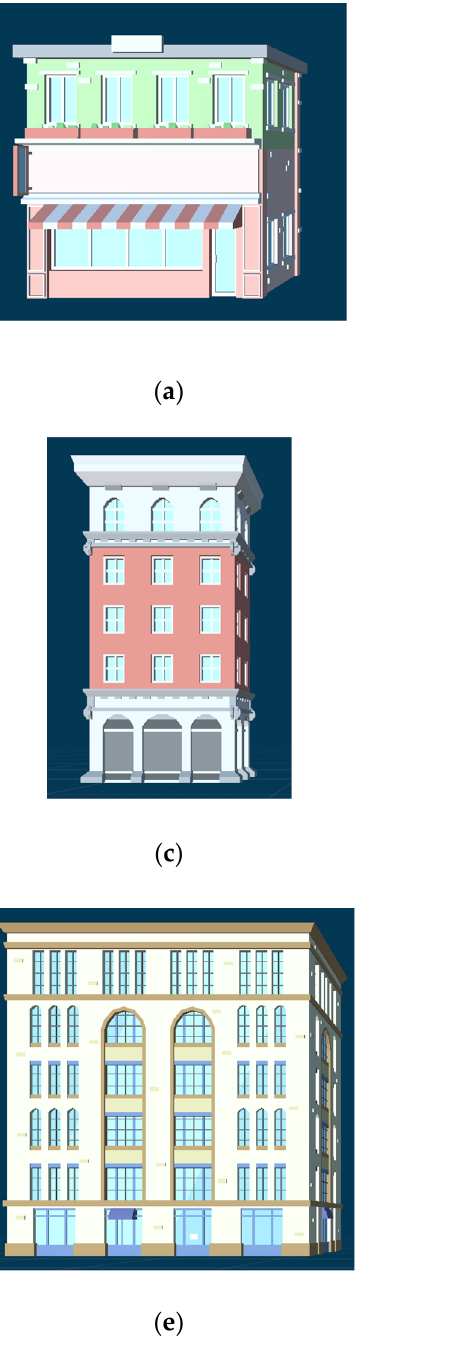
Figure 3. Five types of buildings in the Unity scene: ( a ) HomeType1; ( b ) HomeType2; ( c ) HomeType3; ( d ) CompanyType1; ( e ) CompanyType2. Table 1. Residential building